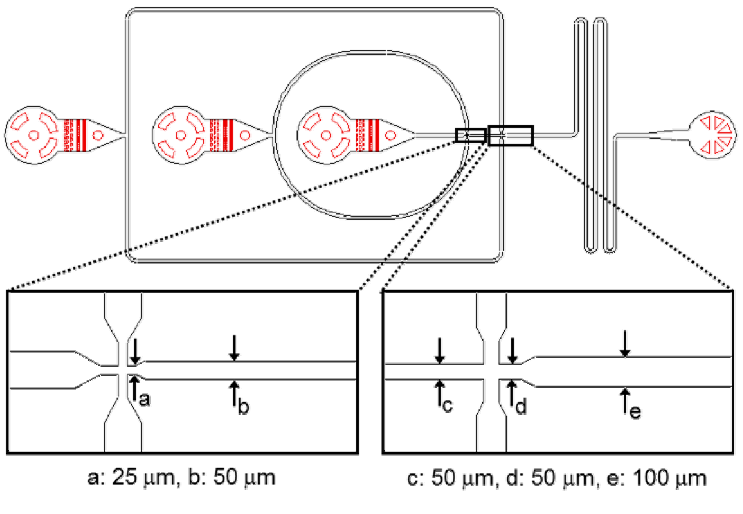
Figure 1. Design of the microfluidic device used for the production of water-in-oil-in-water (w/o/w) double emulsion